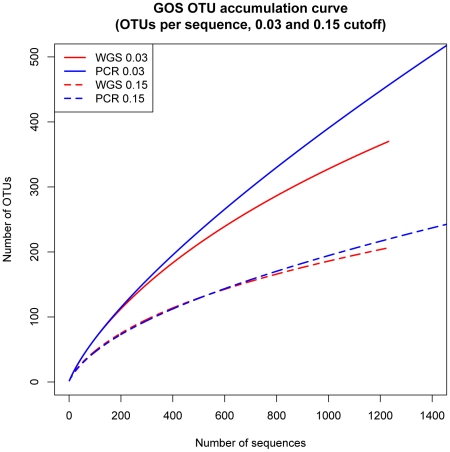
Rarefaction analysis of OTUs identified from PCR and metagenomic sequencing at two different sequence similarity cutoffs (solid = 0.03, dashed = 0.15).Rarefaction curves are shown for OTUs from PCR (blue) and metagenomic (red) sequencing libraries. Two different sequence similarity cutoffs are used (solid = 0.03, dashed = 0.15). Curves represent the average number of OTUs per sequence from 100 random draws of subsets of sequences from each data set.